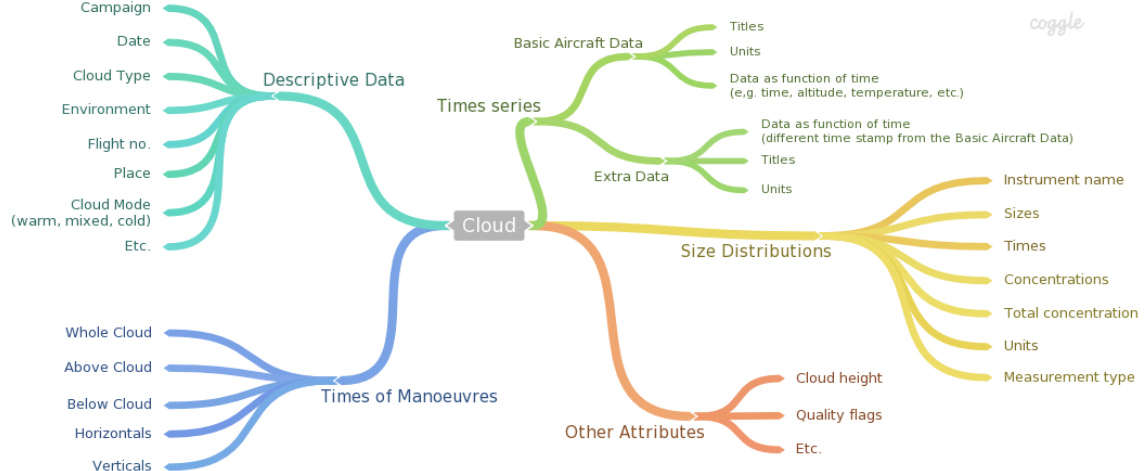
Figure 3. Basic structure of the cloud object. All main sections are created upon initialization of a cloud instance (except for the Descriptive Data section, which is created using the method describe